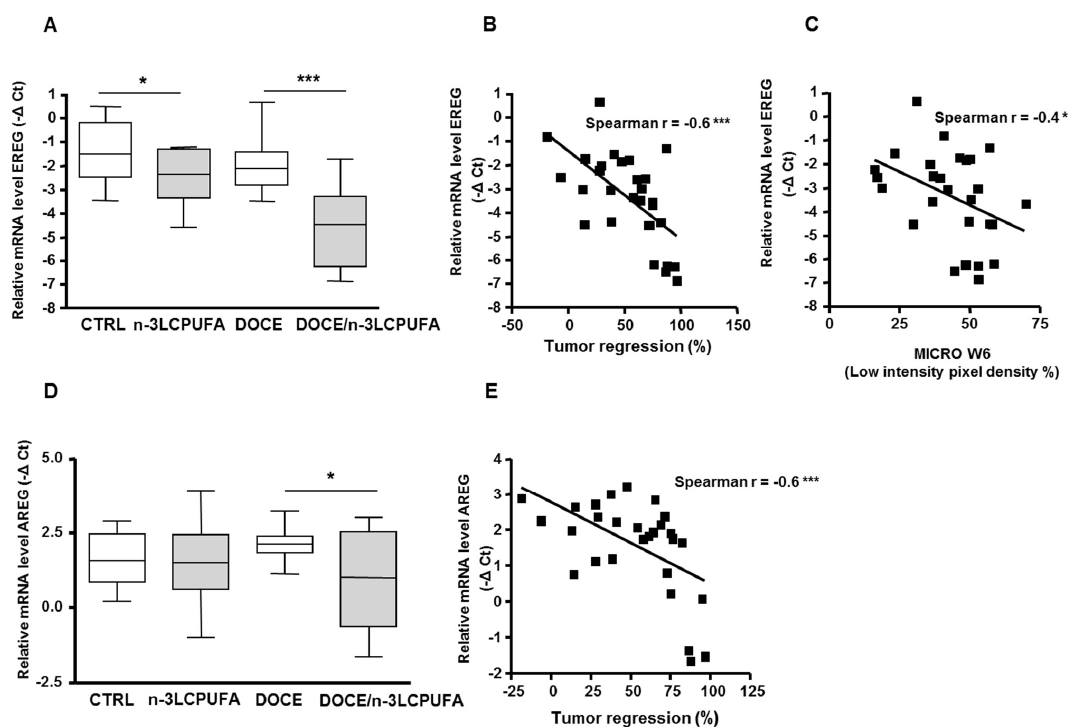
Figure 3. Regulation by n-3 LCPUFA of tumor epiregulin (EREG) and amphiregulin (AREG) mRNA expression levels is associated to tumor regression and microvascular compartment quantification.